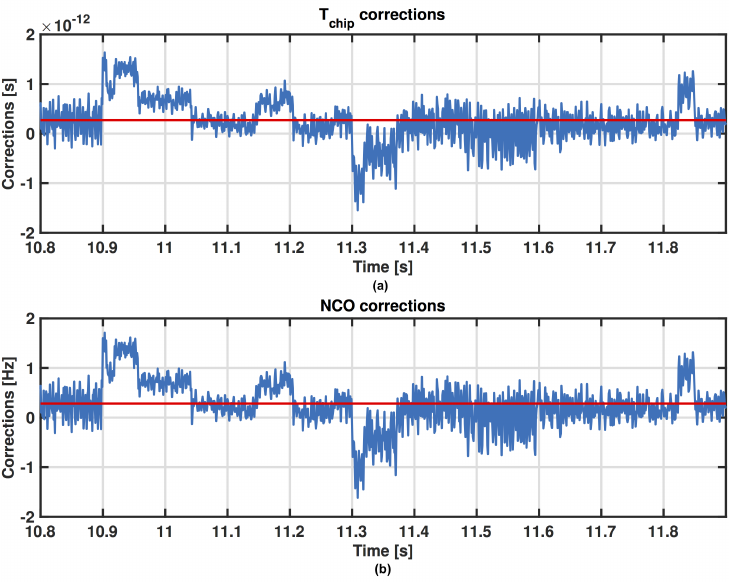
Figure 2. Zoom of the ∆ T chip [ n ] ( a ) and ∆ f c [ n ] ( b ) for PRN 31 in the first time window of Table